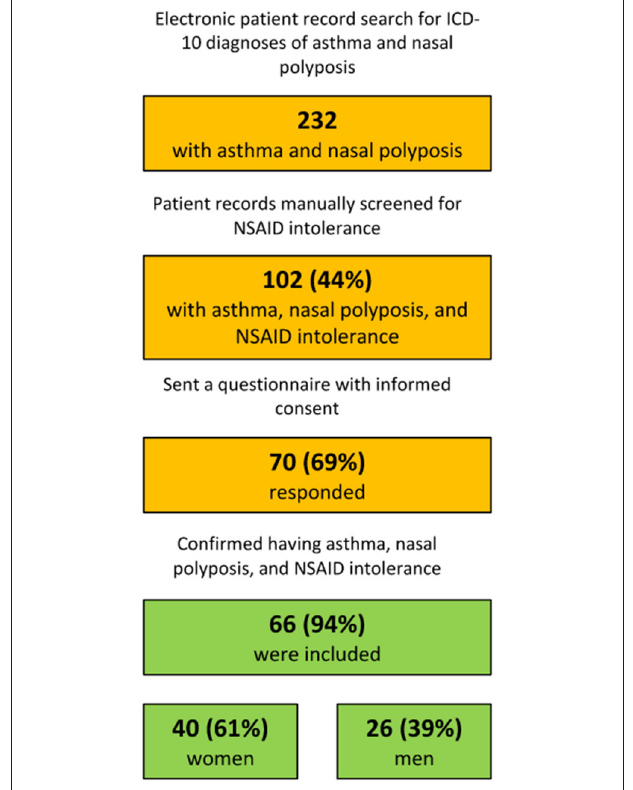
FIGURE 1 | Patient retrieving